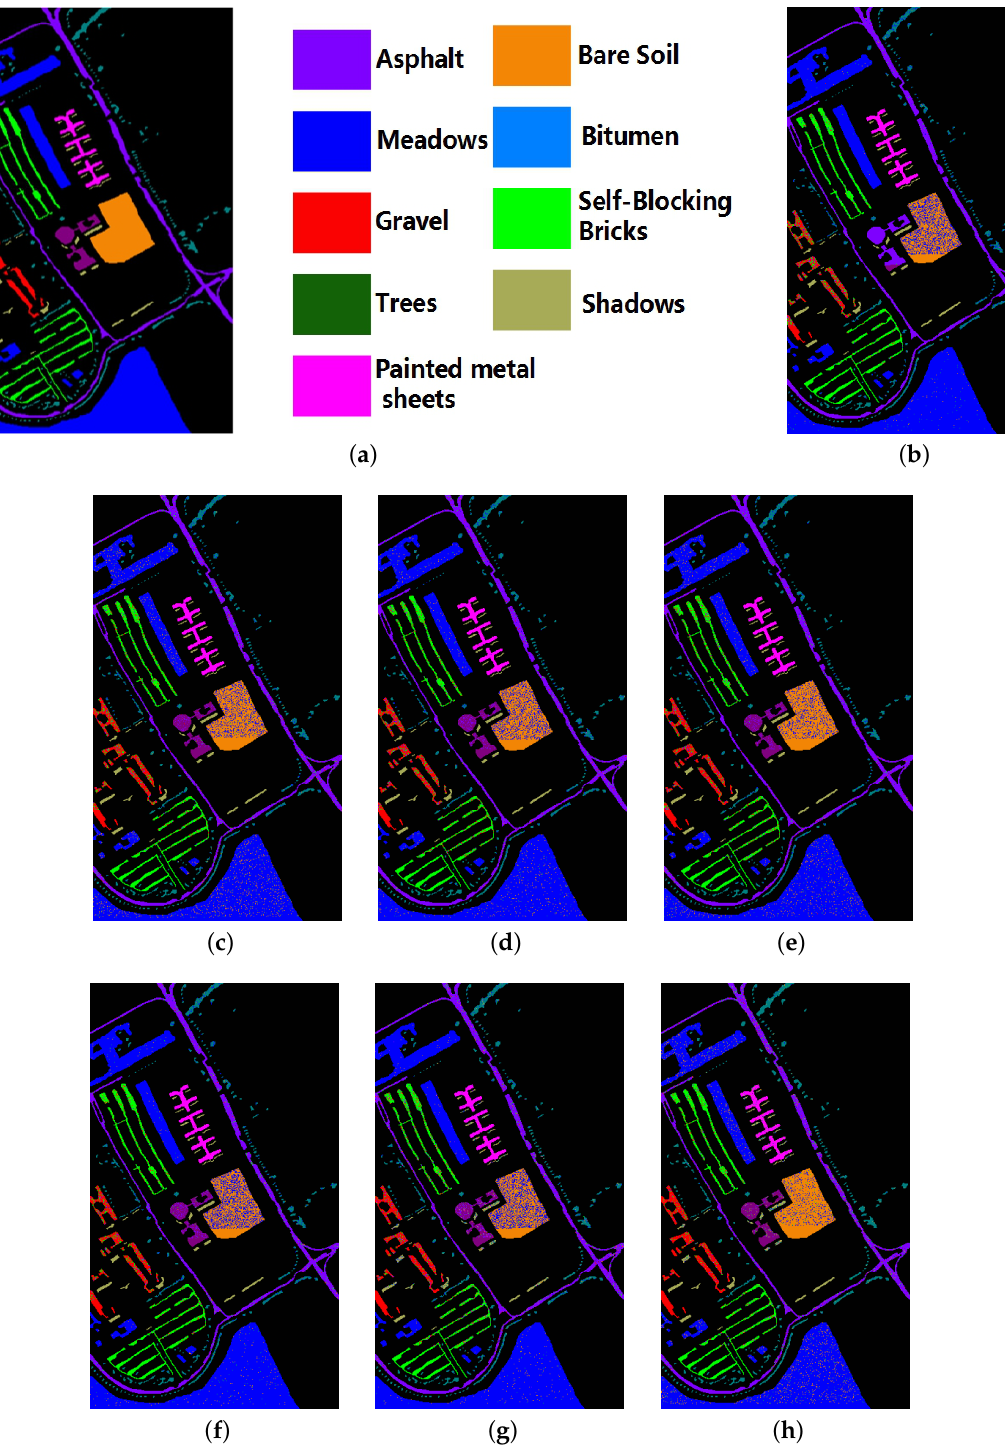
Figure 6. Ground truth (GT) and classification maps of SVM, RF, RoF, CNN, SMOTE-RoF, RBDF as well as the pro- posed SMOTE-WDRoF method on the hyperspectral data the University of Pavia ROSIS . ( a ) GT. ( b ) SVM. ( c ) RF. ( d ) RoF. ( e ) SMOTE-RoF. ( f ) CNN. ( g ) RBDF. ( h )